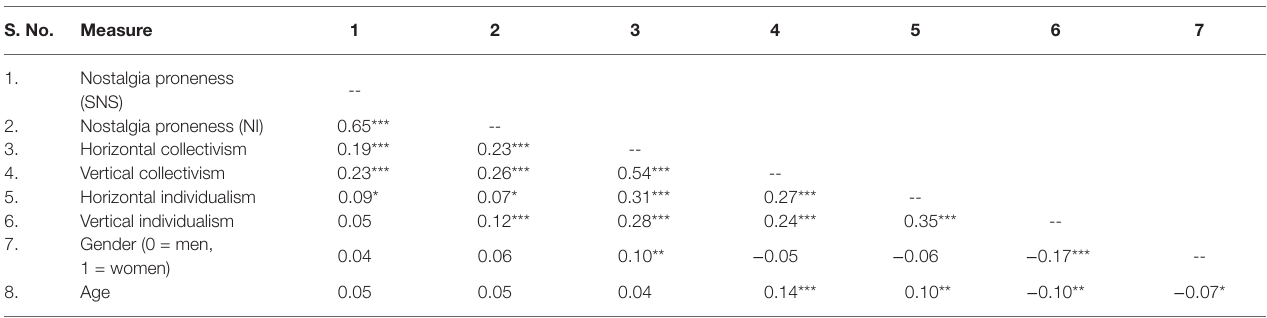
TABLE 1 | Correlations among nostalgia proneness, collectivism, individualism, and demographics in Study 1. S.